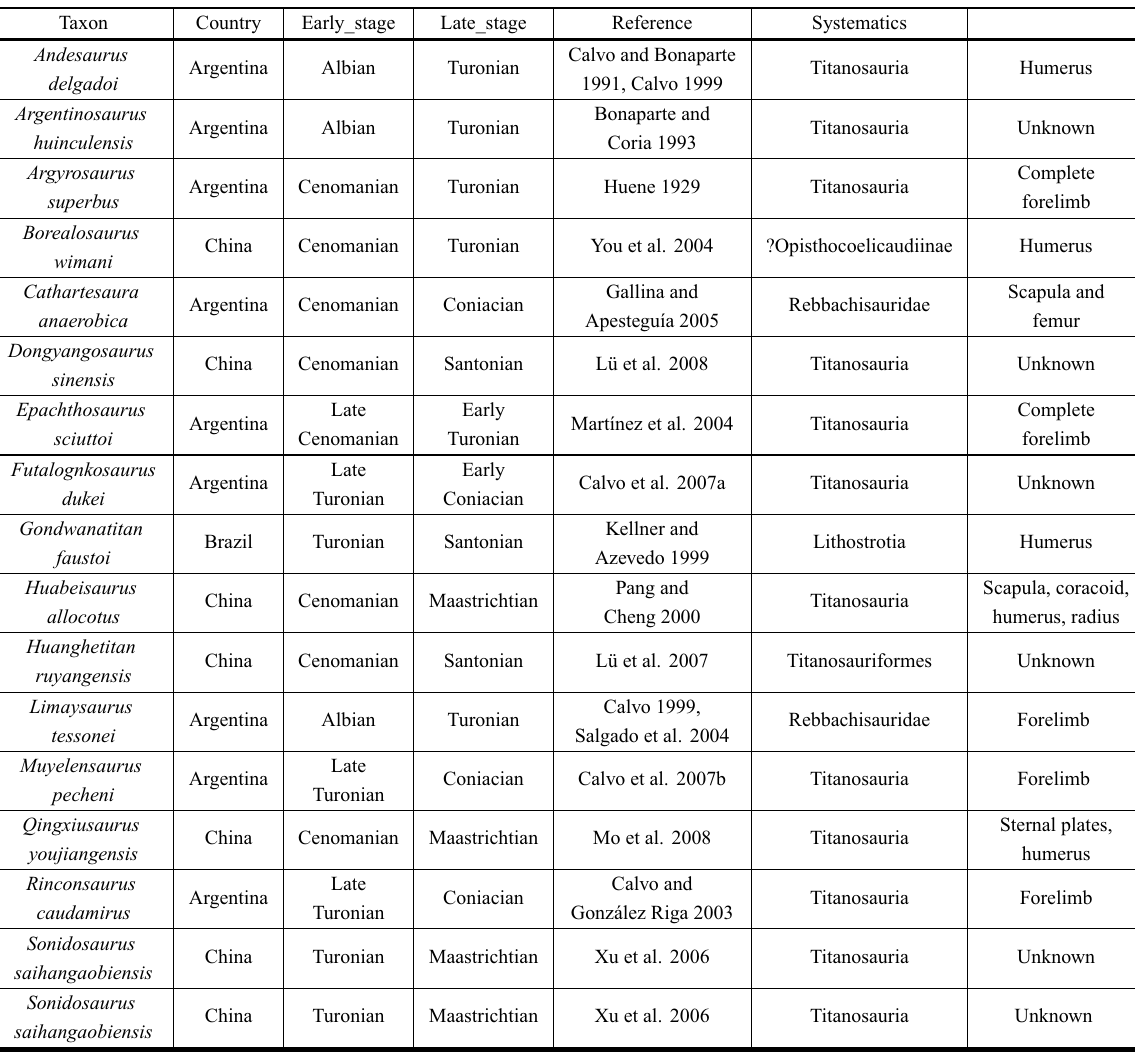
Circa-Turonian sauropod